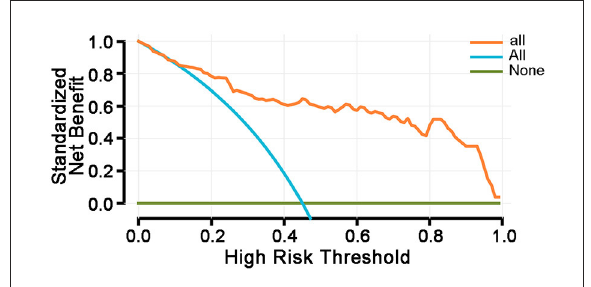
FIGURE5 Decision curve analysis. Survival rates (net benefit rates) were compared for three different decisions. The three curves represent: (1) all patients have no factors that influence the risk of developing PTCI (represented by NONE, horizontal line), (2) all patients are at risk of developing PTCI (represented by ALL, slash), and (3) he decision curve of this study. This prediction model can be used for clinical decision-making. Thresholds are in the range of < 85%, and the model has a higher survival rate (net benefit rate) relative to ALL or